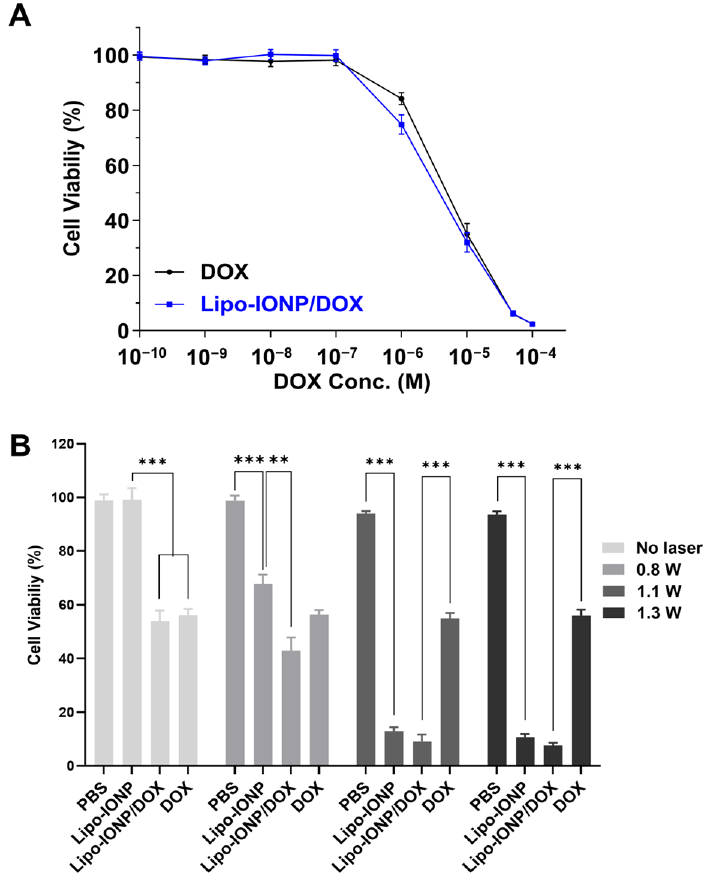
Figure 6. Cytotoxicity of Lipo-IONP/DOX. ( A ) Cytotoxicity profiles of Lipo-IONP/DOX versus DOX alone. ( B ) The viability of cells treated with Lipo-IONP, Lipo-IONP/DOX, and DOX with laser irradiation at different powers. The 0.8, 1.1, and 1.3 W were available to induce maximum medium temperatures of 40, 45, and 50 ◦ C, respectively. The Lipo-IONP/DOX and DOX alone showed similar cytotoxicity levels. However, compared to Lipo-IONP, the Lipo-IONP/DOX elicited greater cytotoxicity. Of note, with laser irradiation at high powers (1.1 and 1.3 W), markedly enhanced cytotoxicity was observed from the cells treated with either Lipo-IONP or Lipo-IONP/DOX. In sharp contrast, the DOX-treated cells showed similar levels of cytotoxicity regardless of the laser application. A statistically significant difference among the groups was compared by 1-way ANOVA with Tukey’s multiple comparison test as the post hoc test using Prism software 9.0.2 (GraphPad). ** p < 0.01 and *** p < 0.001 (Lipo-IONP: liposomal iron oxide nanoparticle and Lipo-IONP/DOX: doxorubicin-loaded liposomal iron oxide